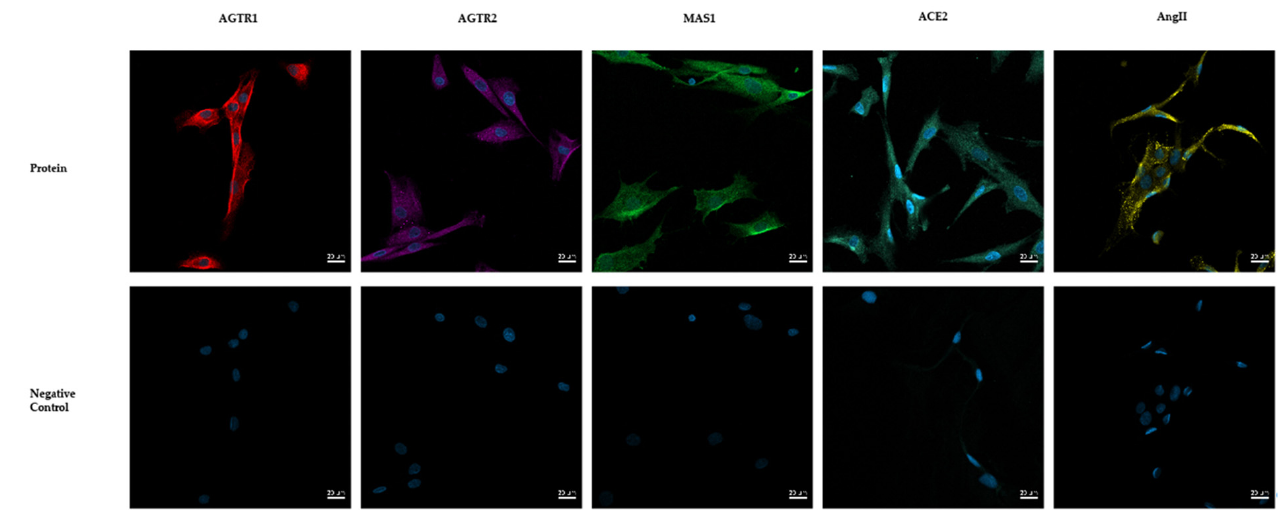
Figure 1. Immunofluorescence analysis of the angiotensin II type 1 (AGTR1) and 2 (AGTR2) and MAS1 receptor, as well as angiotensin II (AngII) and angiotensin-converting enzyme 2 (ACE2). Representative images are shown. n = 4 biological replicates with 2 technical replicates each were evaluated via immunofluorescence. DAPI was used to visualize cell nuclei. Scale bar, 20 µ m.